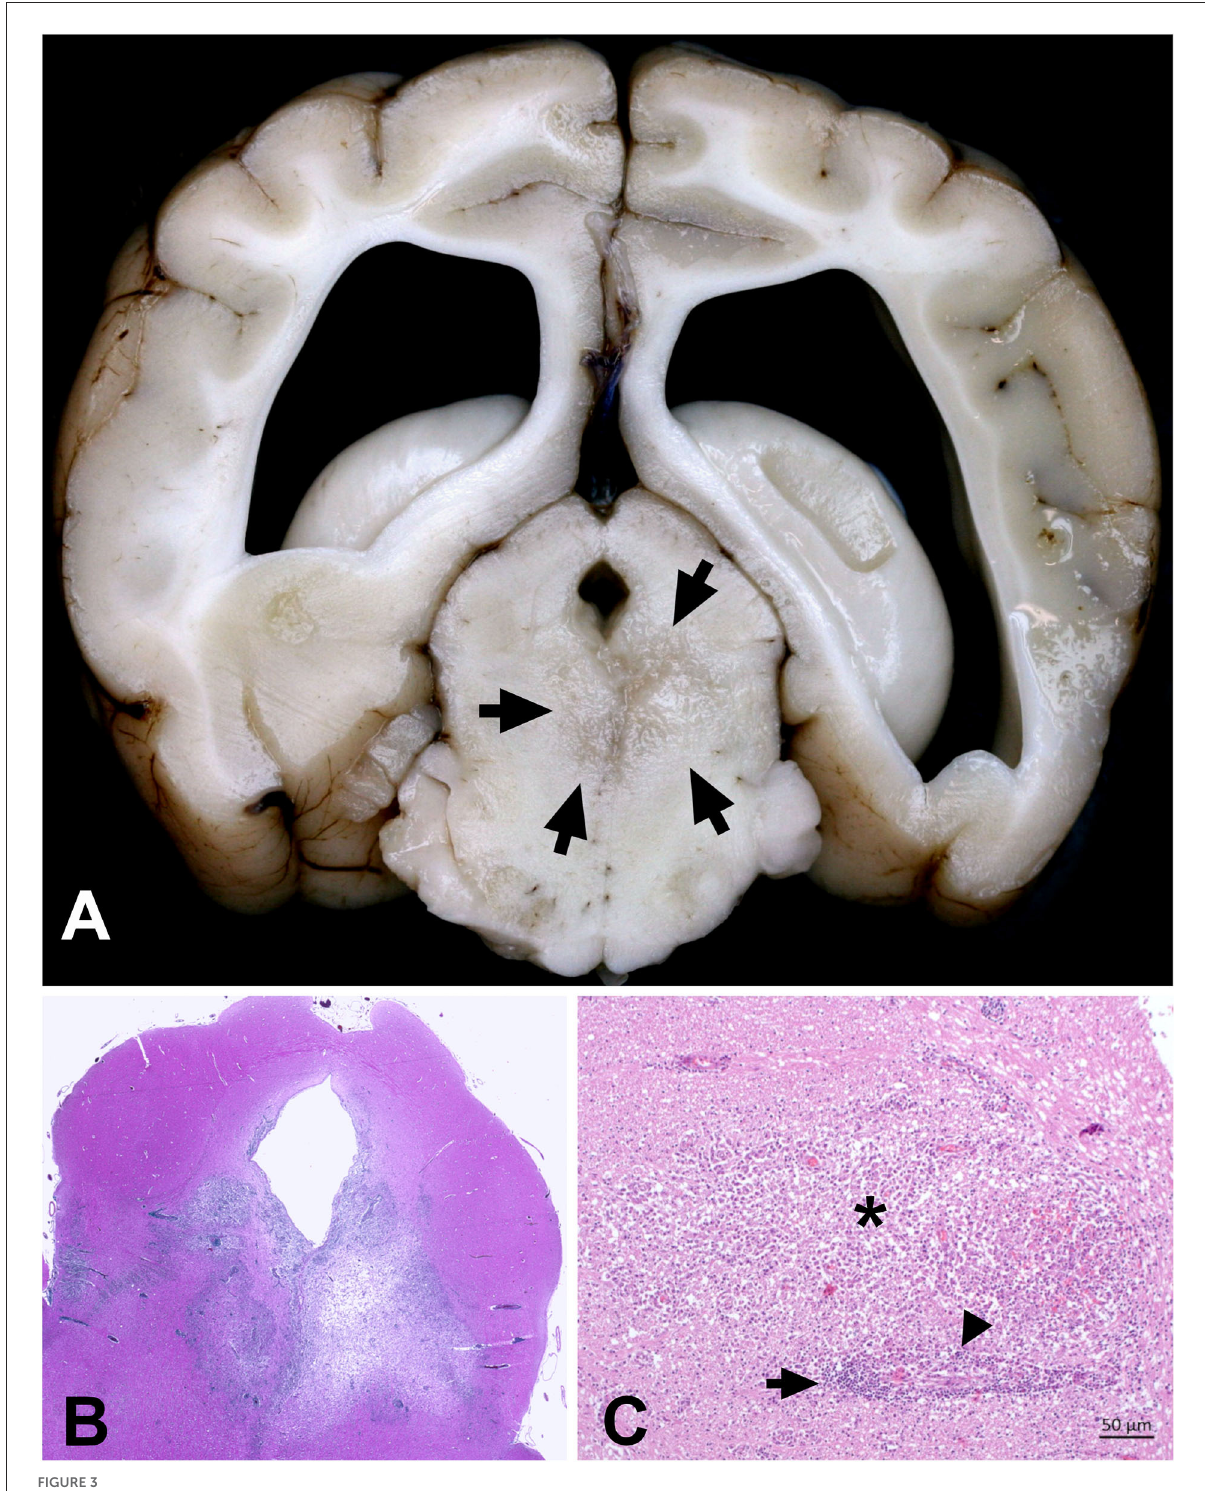
FIGURE3 Combined necrotizing and granulomatous meningoencephalitis in the brain of a Maltese (case 2). (A) Focal-extensive malacia in the midbrain (arrows). (B) Subgross picture of a H&E stained section of the midbrain shown in A. Focal-extensive pallor indicates necrosis and edema, which is associated with a prominent inflammatory process (dark blue color due to nuclei of infiltrating inflammatory cells). (C) Area of granulomatous inflammation with lymphocytes (arrows) and activated macrophages (arrowheads) around a vessel. The activated macrophages markedly extend into the neuroparenchyma